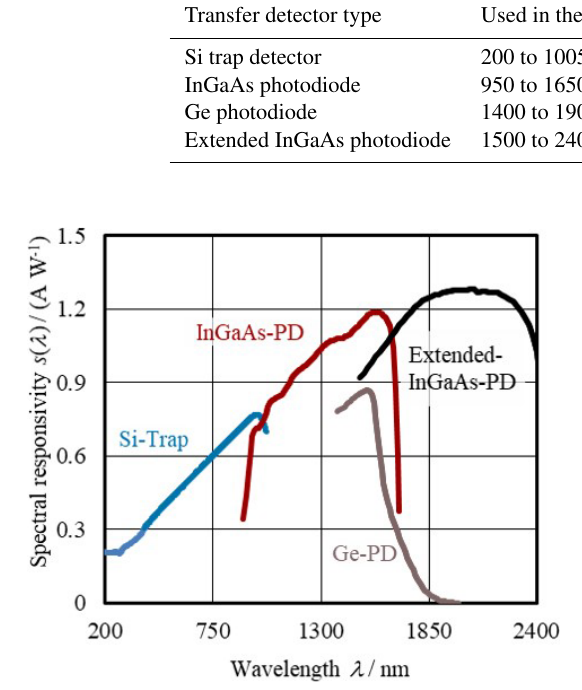
Figure 1. Spectral responsivity of transfer detectors in the UV, VIS and NIR (PD: photodiode; trap: detector made of three photodiodes in a “trap